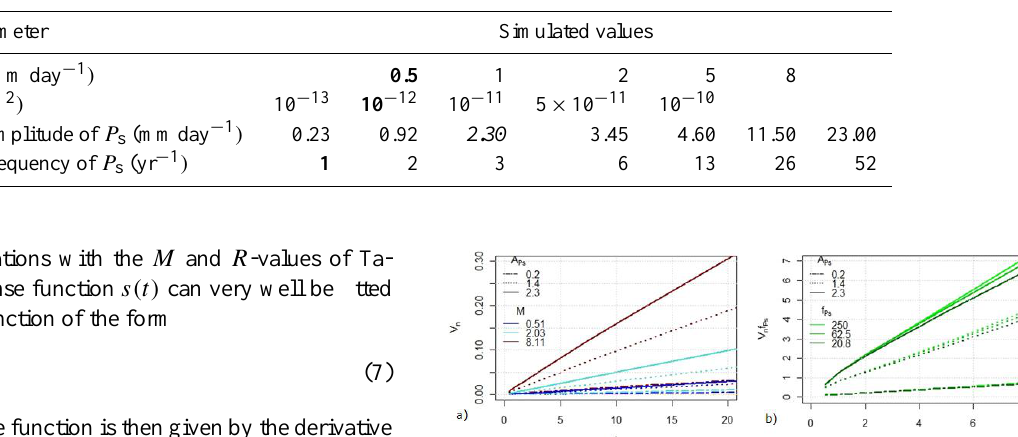
Table 2. Parameter variation of seepage ( S ), permeability ( κ ) and for the parameters of precipitation sinusoidal function ( P s with P =1, Eq. 5), for which the reference situation (bold values) is De Bilt, www.knmi.nl.